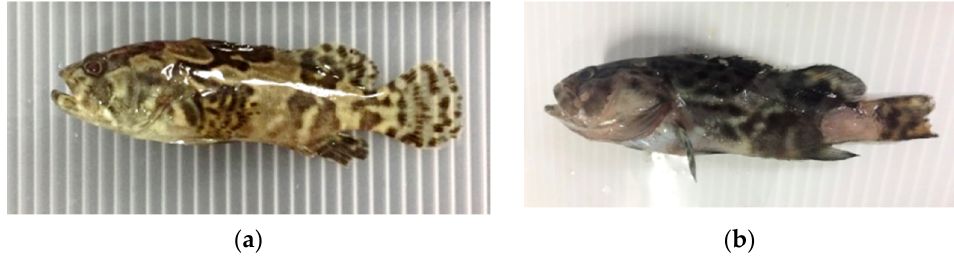
Figure 2. Picture of grouper with no bacteria challenge ( a ). Physical symptoms of grouper challenged with V. vulnificus ( b ). Table 4. Survival rate and blood cell counts of hybrid grouper fed with different fatty acid diets after 7-day of post-bacterial challenge. Control Oleic Acid Stearic Acid Behenic Acid Palmitic Acid Total survival/initial fish used